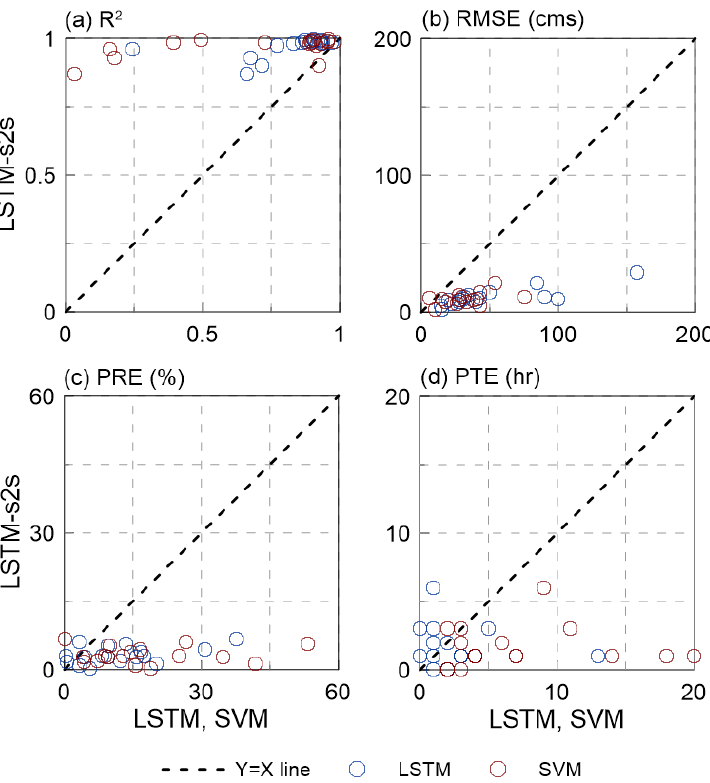
Figure 8. Scatter plots showing the performance of the LSTM-s2s model compared to other models for event-based runoff prediction using four metrics. ( a – d ) indicate four metrics, R 2 , RMSE, PRE, and PTE.